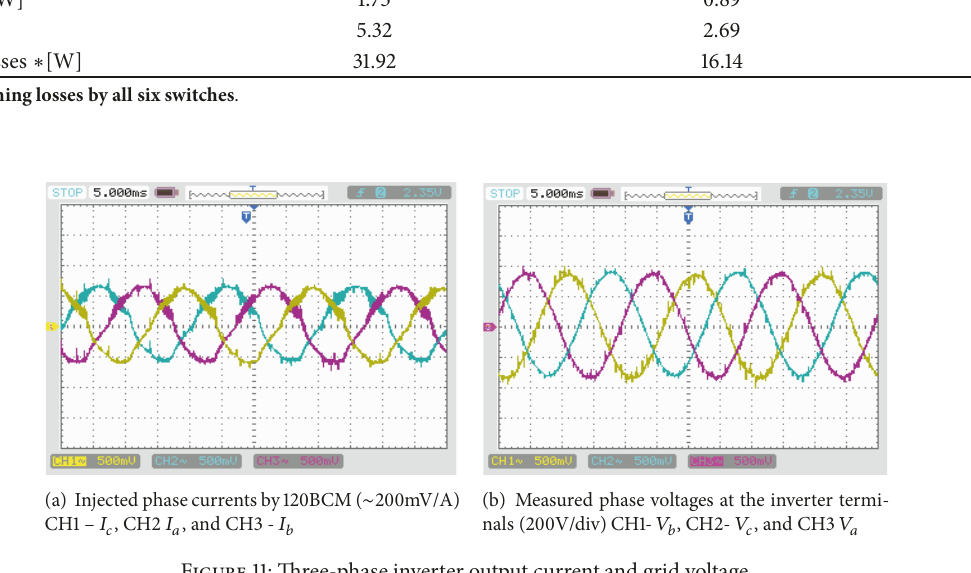
Figure 11: Three-phase inverter output current and grid